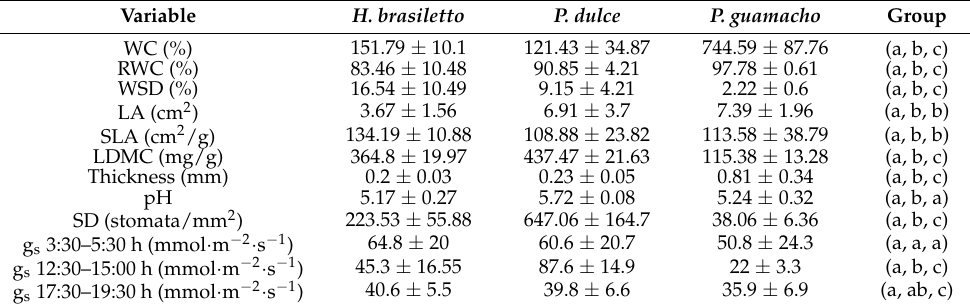
Table 1. Functional traits in leaves of H. brasiletto , P. dulce , and P. guamacho .